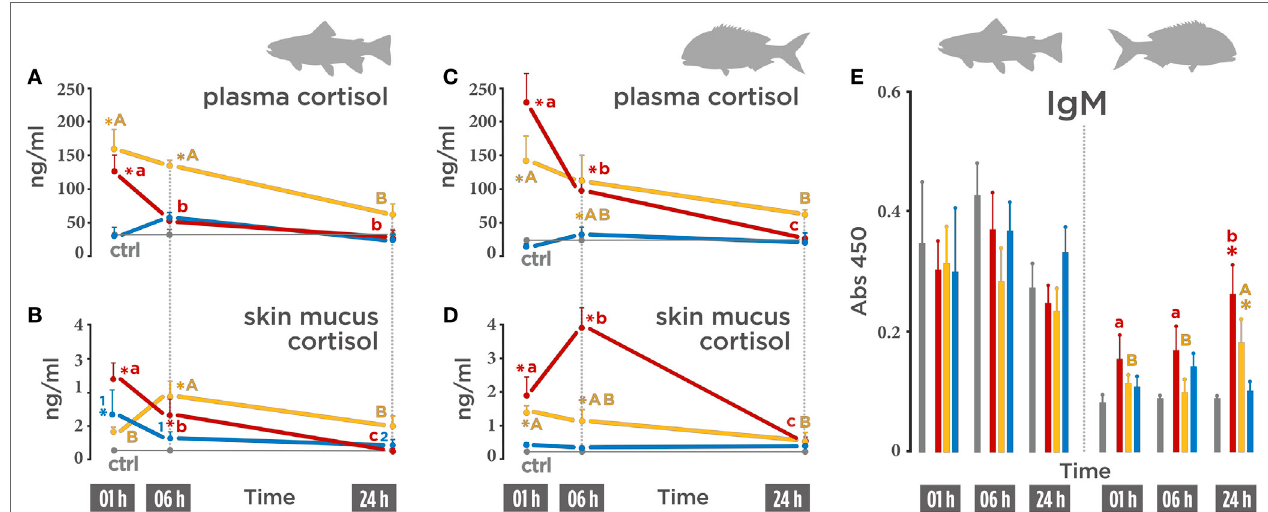
FigUre 1 | Cortisol and IgM levels on biotic ( Vibrio anguillarum bacterin), abiotic (air exposure), or the combination of both stressors (vaccine + air exposure) at 1, 6, and 24 h post-stress. (a) Rainbow trout plasmatic cortisol (ng/ml). (B) Rainbow trout skin mucus (ng/ml) cortisol. (c) Gilthead seabream plasmatic cortisol. (D) Gilthead seabream skin mucus cortisol. (e) Total IgM (Abs 450) in rainbow trout (left side) and seabream (right side). Different colors indicate different treatments: red (air exposure), orange (vaccine + air exposure), blue (vaccine), and gray (ctrl; control). Time zero represents the end of the acute air exposure stress (for the air exposure and the vaccine + air exposure) or 24 h after bath vaccination (for vaccine group). Data are represented as mean ± SE ( n = 8 per sampling time point). Significant differences are indicated by lower case in the air exposure group, by upper case in the vaccine + air exposure group, and by numbers in the vaccine group. Asterisk (*) indicates significant difference of each treatment versus control ( p <